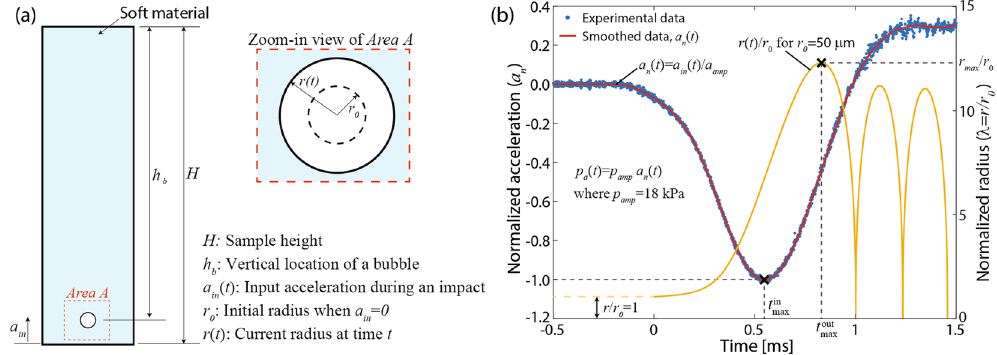
Figure 4. ( a ) Schematic of a spherical air bubble in a soft material sample. ( b ) Transient dynamics of a bubble for the initial radius r 0 = 50 μ m due to external acceleration ( a in ) induced by mechanical